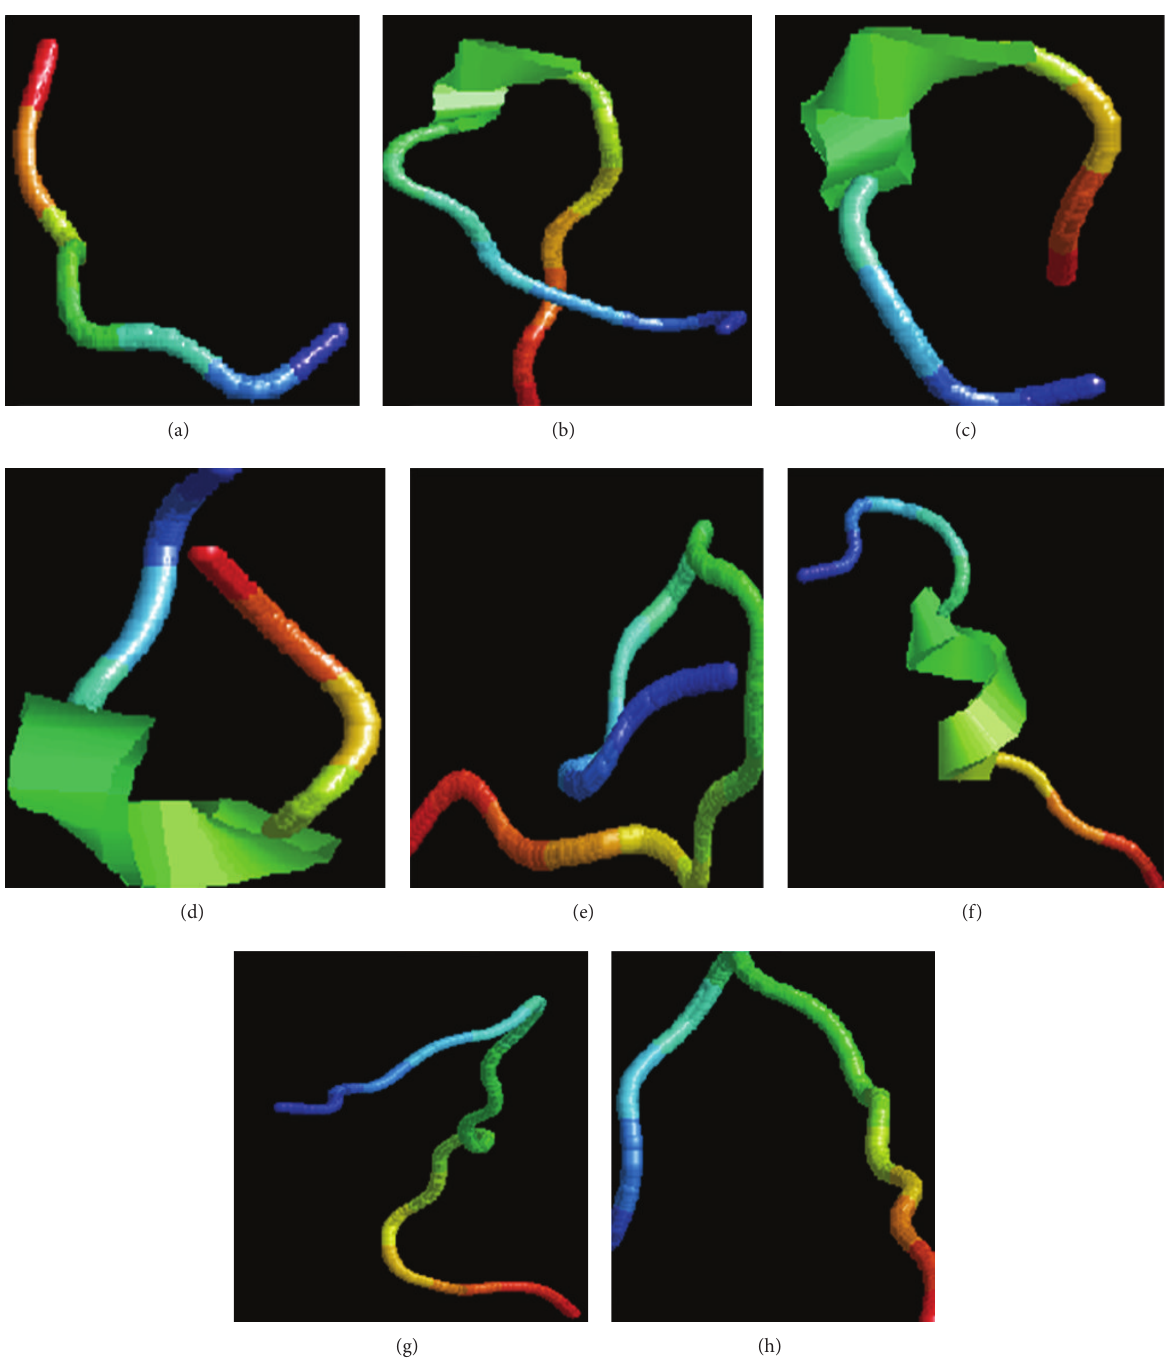
Figure 8: Ribbon representation of the modeled oligopeptides. (a) KREAKQEE, (b) PGKFYVSSGATTFPAVYL, (c) PGKYKLAVSEK, (d) PGPTVFPAVLY, (e) PSTLSVSSGTVYEKHEGLS, (f) QTAMRMIFTALTSPS, (g) QVGFSSTAMWNKTFDVSGATQ, and (h) SGVQPDAP-